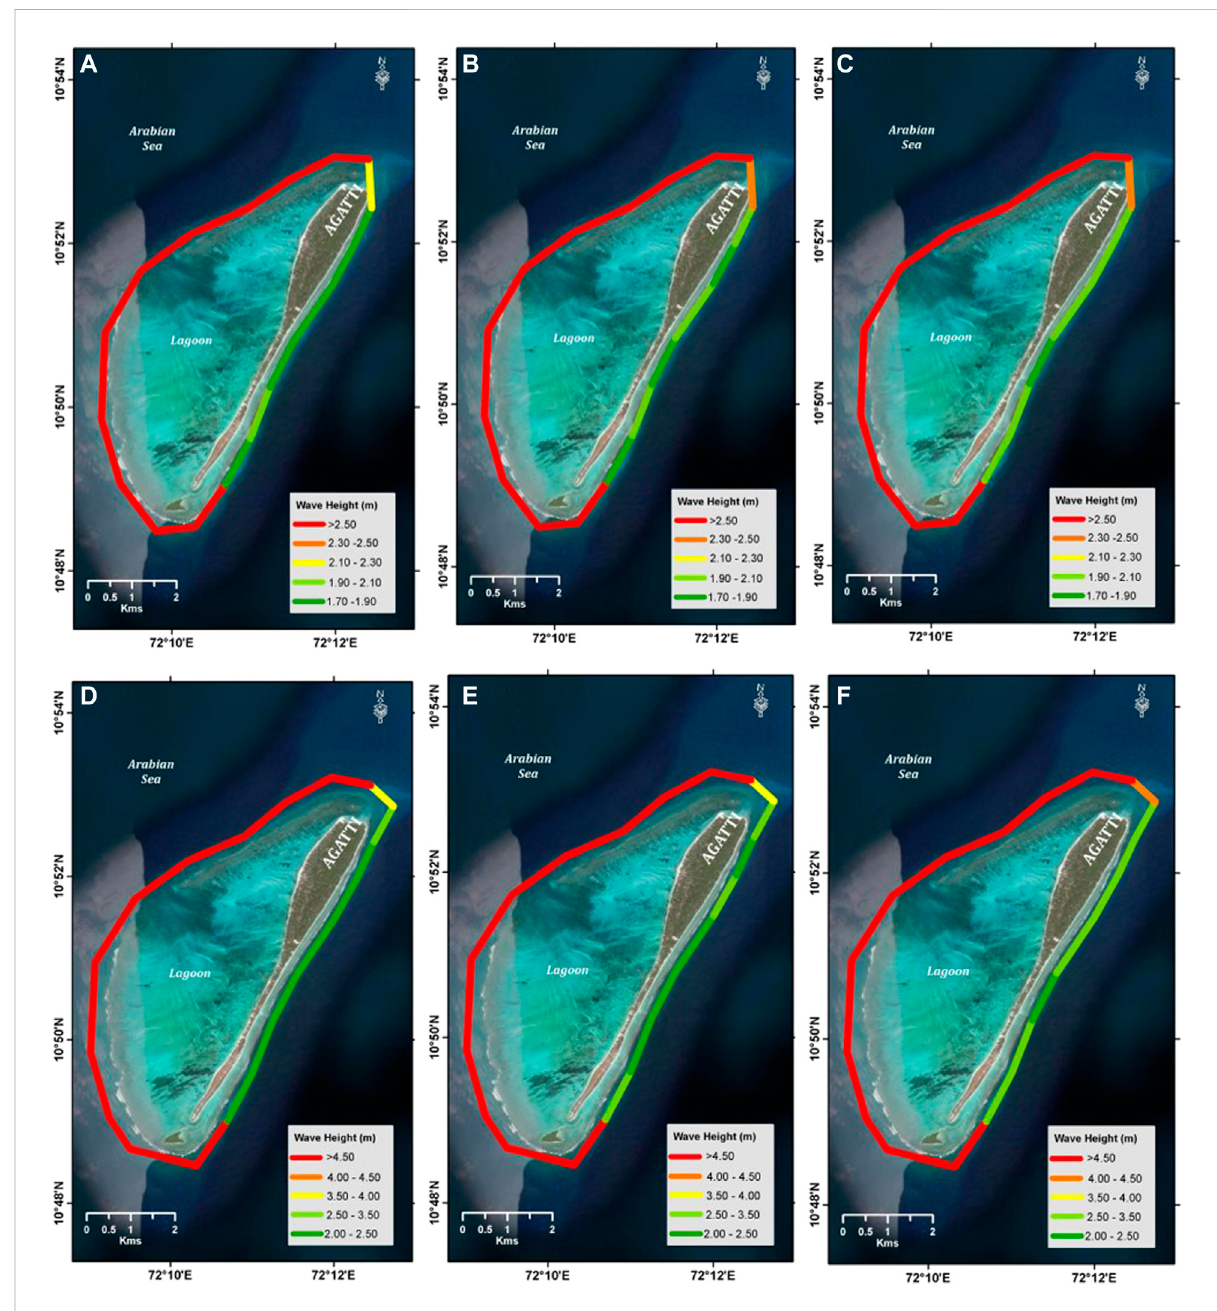
waves approaching island from different directions. During monsoon the average value of wave power reaches its maximum up to 8.8 kW/m and 15 kW/m for North and South zone respectively. During pre monsoon and post monsoon, the average value of wave power is 2.7 kW/m